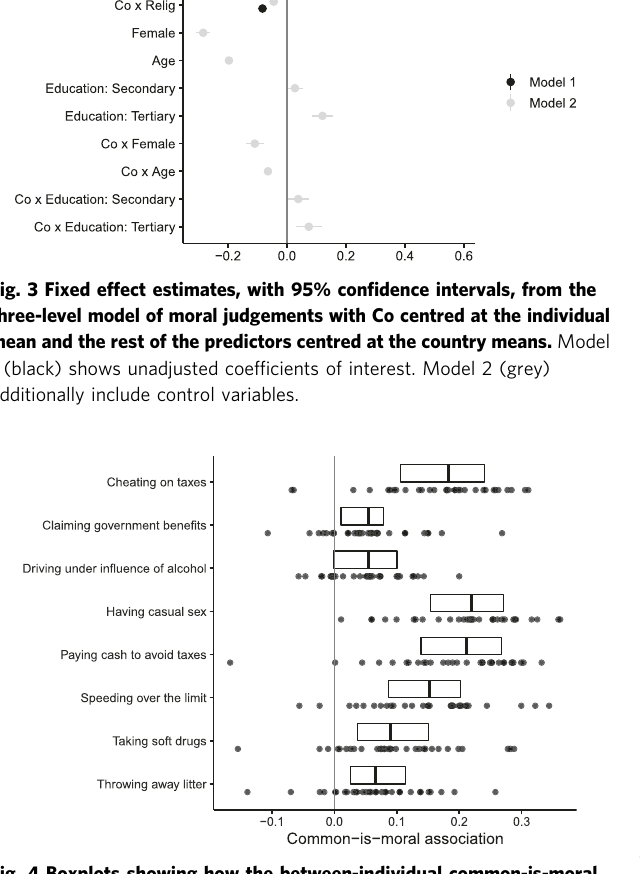
Fig. 4 Boxplots showing how the between-individual common-is-moral association for eight questionable behaviours varied across 31 countries in the European Values Study. Boxes indicate the interquartile range, with the dark line in the box indicating the median. Below each box, the exact distribution is represented by dots. Table 1. The fi nding of a within-individual common-is-moral association is represented by the positive coef fi cient of common- ness (Co). The fi nding that the common-is-moral association is lower among more religious people is represented by the negative coef fi cient for the interaction of commonness and religiosity (Co × Relig). Both effects remain solid after inclusion of the control variables and their interaction with religiosity in the model. Figure 3 further shows that highly educated people tended to give higher ratings for the morality of questionable behaviours while religious people, females, and older people tended to give lower ratings. The common-is-moral association is also lower among women, older, and less educated; these additional fi ndings are interesting but beyond the scope of this paper.